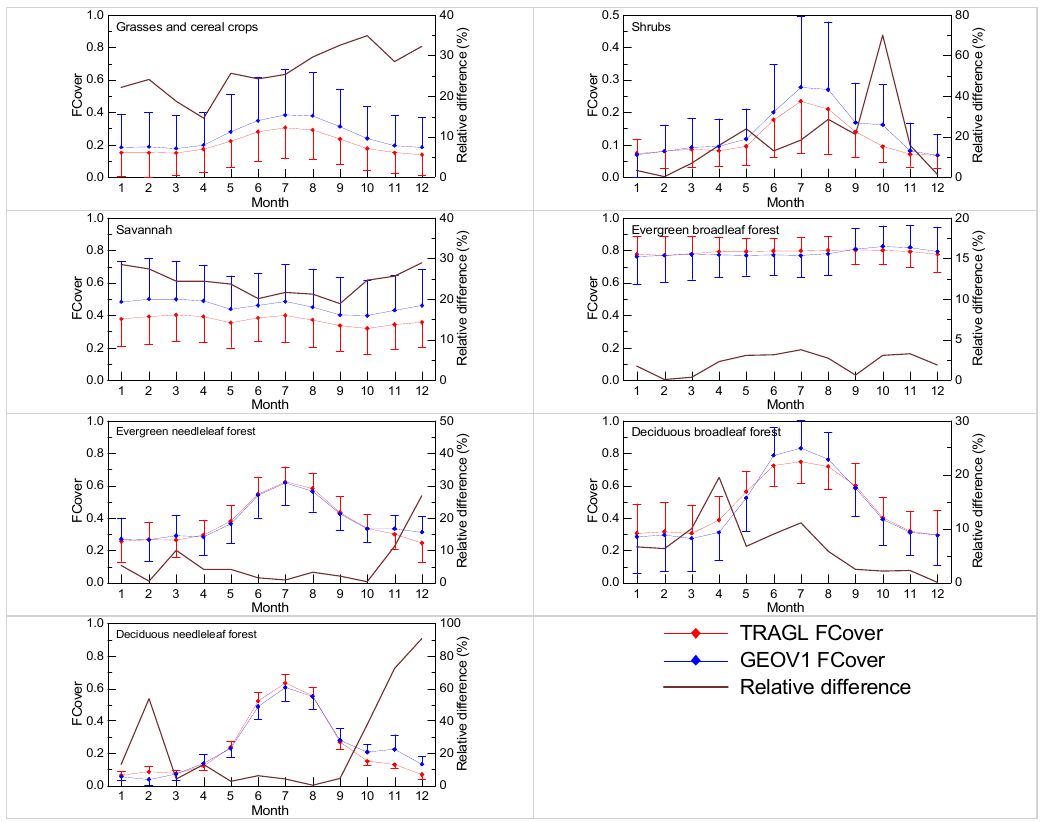
Figure 5. Mean values of TRAGL and GEOV1 FCover products for different biome types in each month for 2001–2005 and their relative differences.